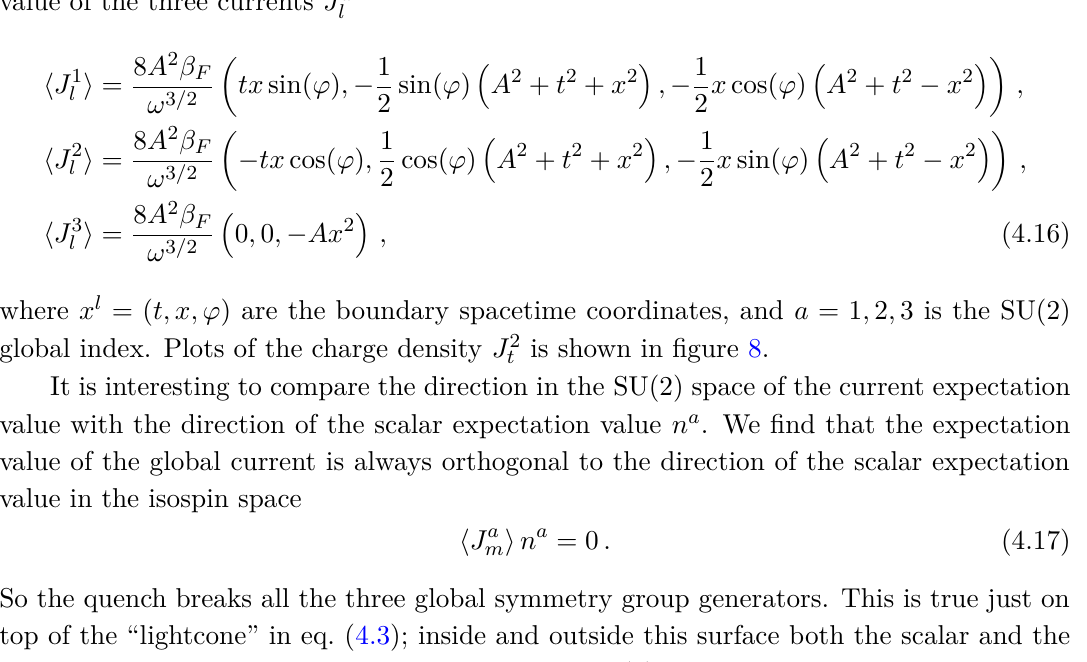
Figure 8 : Charge density of the second component of isospin J 2 ϕ = 0 (positive x ) and ϕ = π (negative x ). We set A = 1 , α the relations in eq. (2.19), valid for small backreaction. The peak and the pit correspond to positive and negative sign global charges, which are taken apart from each other by the